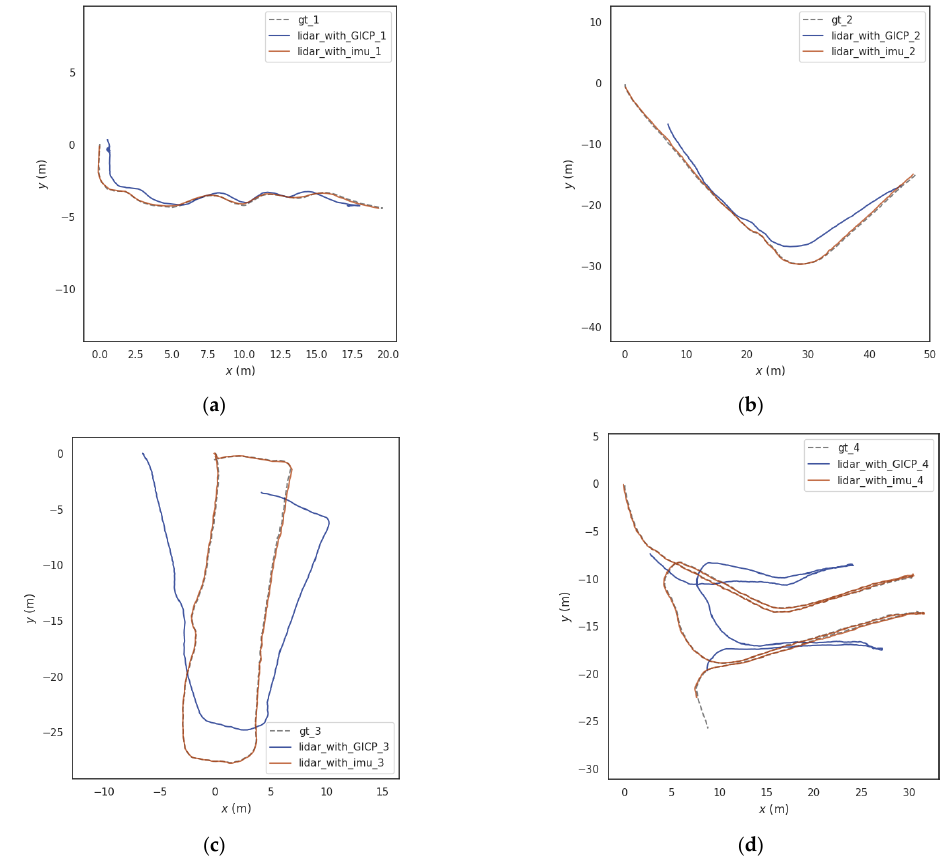
Figure 12. Comparison of the trajectories of LiDAR odometry constructed by different point cloud registration algorithms. ( a ) Track comparison of experiment 1; ( b ) Track comparison of experiment 2; ( c ) Track comparison of experiment 3; ( d ) Track comparison of experiment 4.